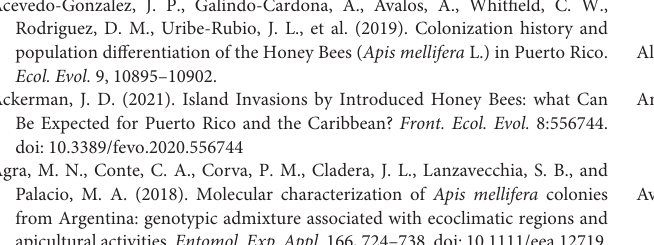
Supplementary Figure 1 | Principal coordinate analysis (PCoA) scatterplot for colonies based on selected morphometric and behavioral variables (Gower distances). Twelve variables were included in this analysis (selected according to their coefficient values in PCA; Supplementary Table 4 ) as follows: ProbL, G5,